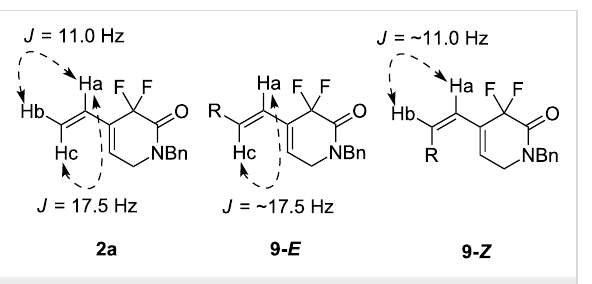
Figure 1: Comparison of coupling constant of vinyl protons.